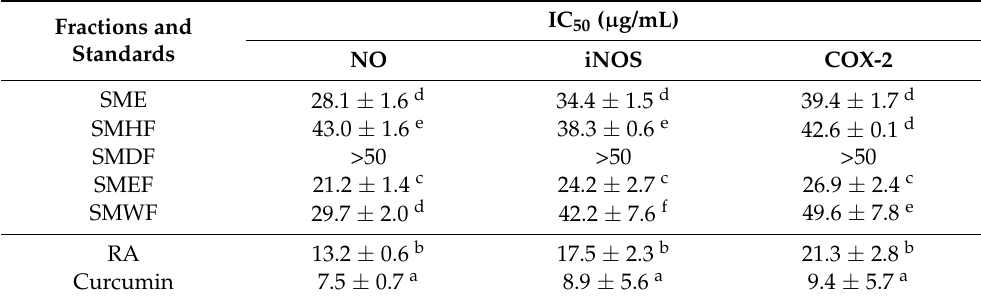
Table 2. Anti-inflammatory activity as IC 50 of PSM fractions determined by a Griess reaction assay and ELISA using RA and curcumin as positive control.